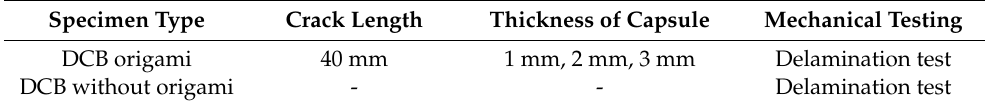
Table 4. Experiment Scheme in embedded